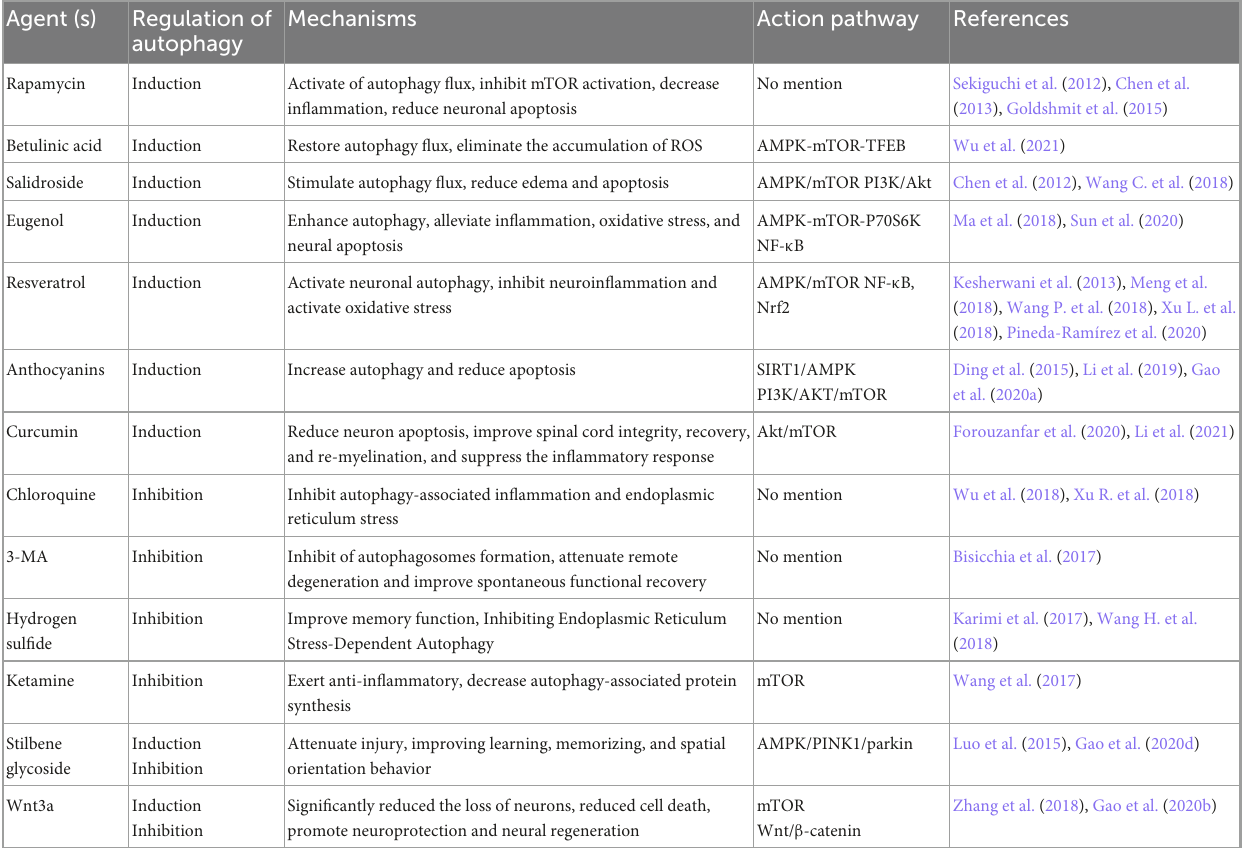
TABLE 1 Autophagy-targeted therapeutic agents for neuroprotection and functional recovery in central nervous